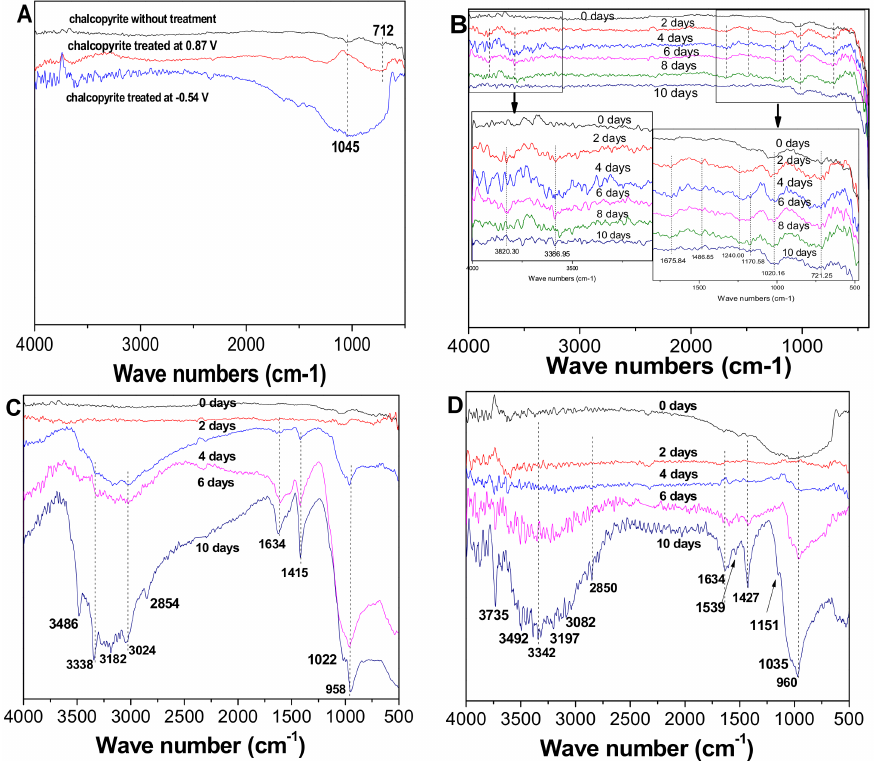
Figure 6. The Fourier transform infrared (FT-IR) spectra of chalcopyrite leaching residues. ( A ) Sterile chalcopyrite; ( B ) Bioleached chalcopyrite untreated; ( C ) Bioleached chalcopyrite treated at 0.87 V; ( D ) Bioleached chalcopyrite treated at − 0.54